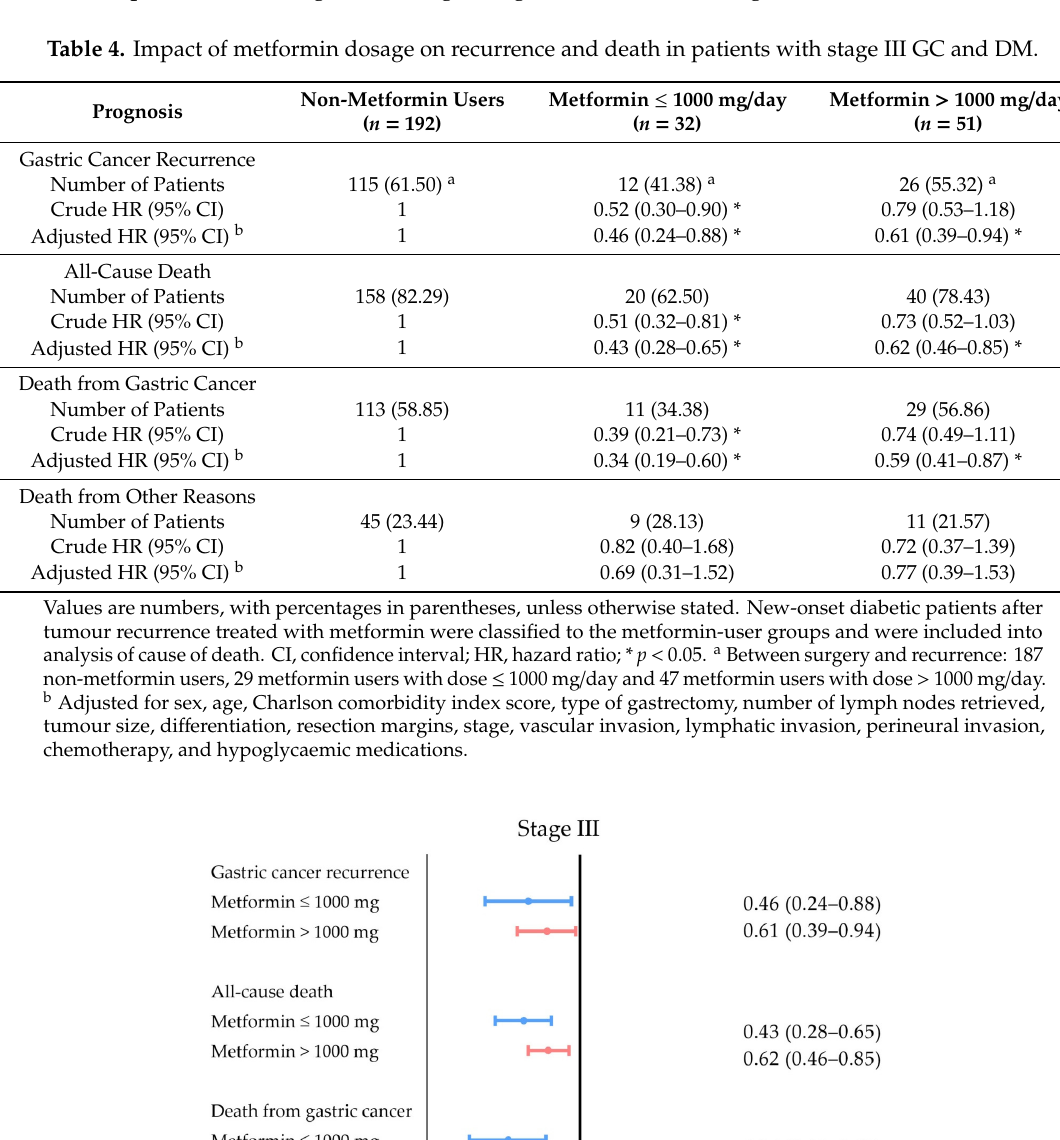
Table 4. Impact of metformin dosage on recurrence and death in patients with stage III GC and DM.